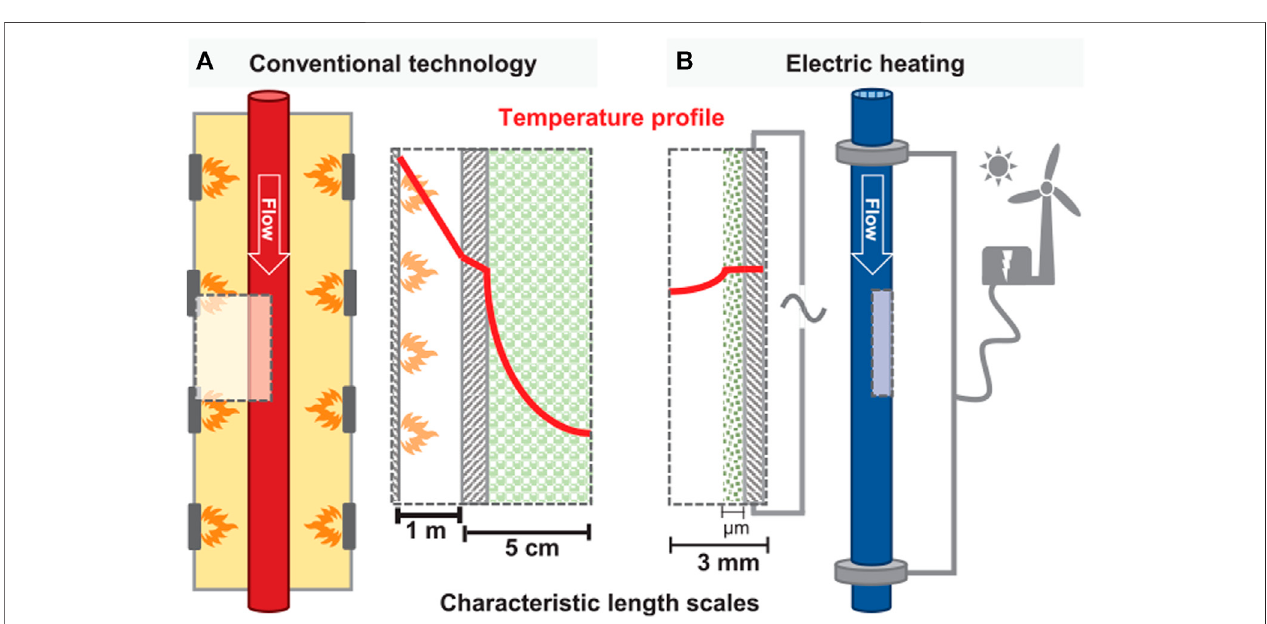
FIGURE 7 | Schematic representation of reactor scale and temperature pro fi les in conventional reformers (A) and in the electri fi ed reformer (B) (Wismann et al., 2019a).